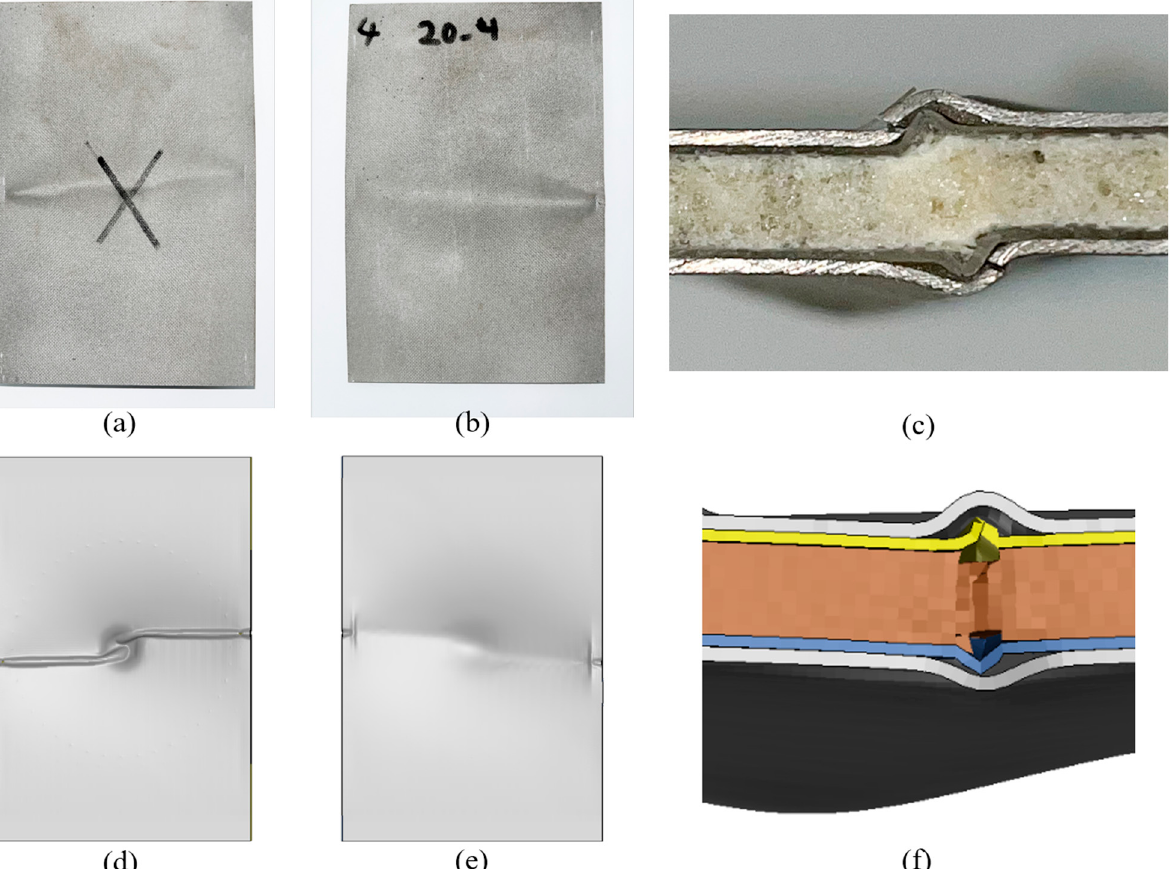
Figure 15. Experimental and numerically predicted CAI failure modes of 3DFML: ( a ) impacted side; ( b ) unimpacted side; ( c ) detailed side view of failure; ( d ) numerical simulation of the impacted side; ( e ) numerical simulation of the unimpacted side; ( f ) side view of failure region simulated numerically.